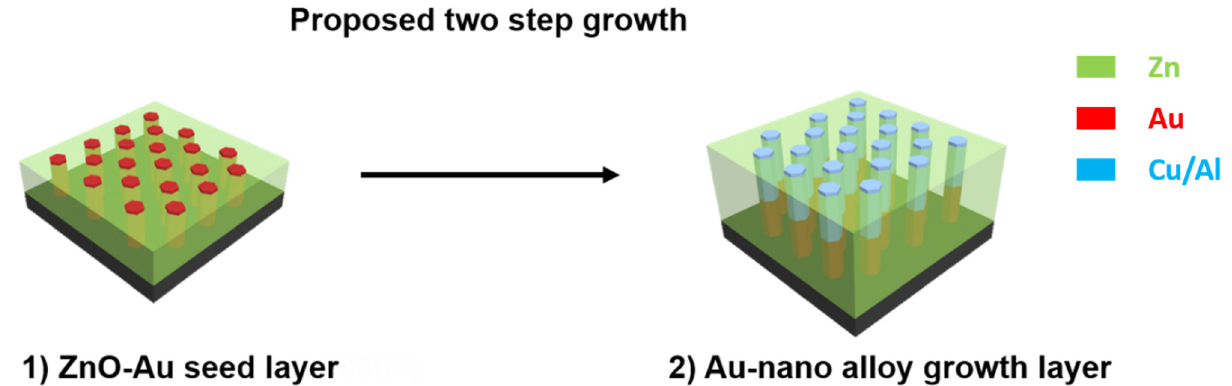
Figure 1. Two-step seeded growth approach was utilized to allow for the formation of low-loss oxide–alloy nanocomposites.